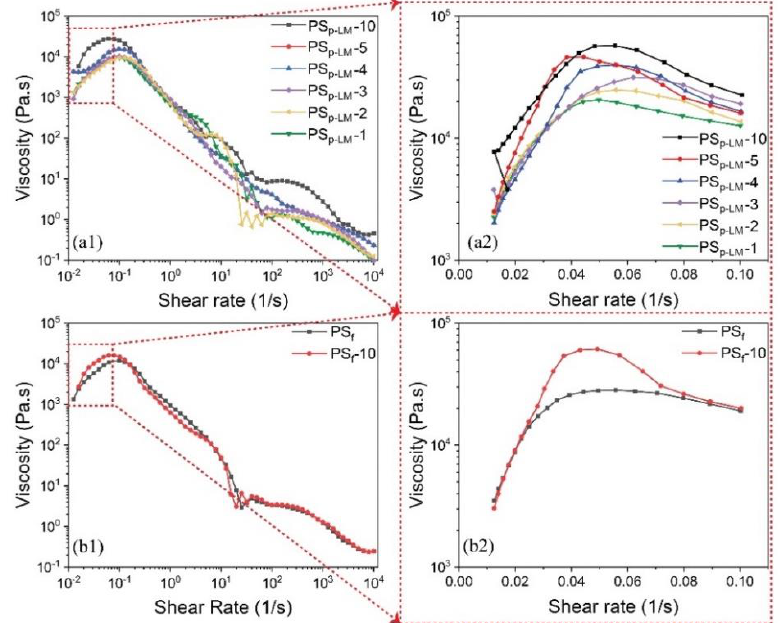
Figure 2. Polyethylene glycol (PEG) / polystyrene (PS) of ( a1 ) 1, 2, 3, 4, 5, and 10 wt. % using low-molecular-weight PS pellets (PSp-LM) and ( a2 ) zoom-in regions at lower shear rates. ( b1 ) 10 wt. % using PS-based packaging foams (PSf) and ( b2 ) zoom-in regions at lower shear